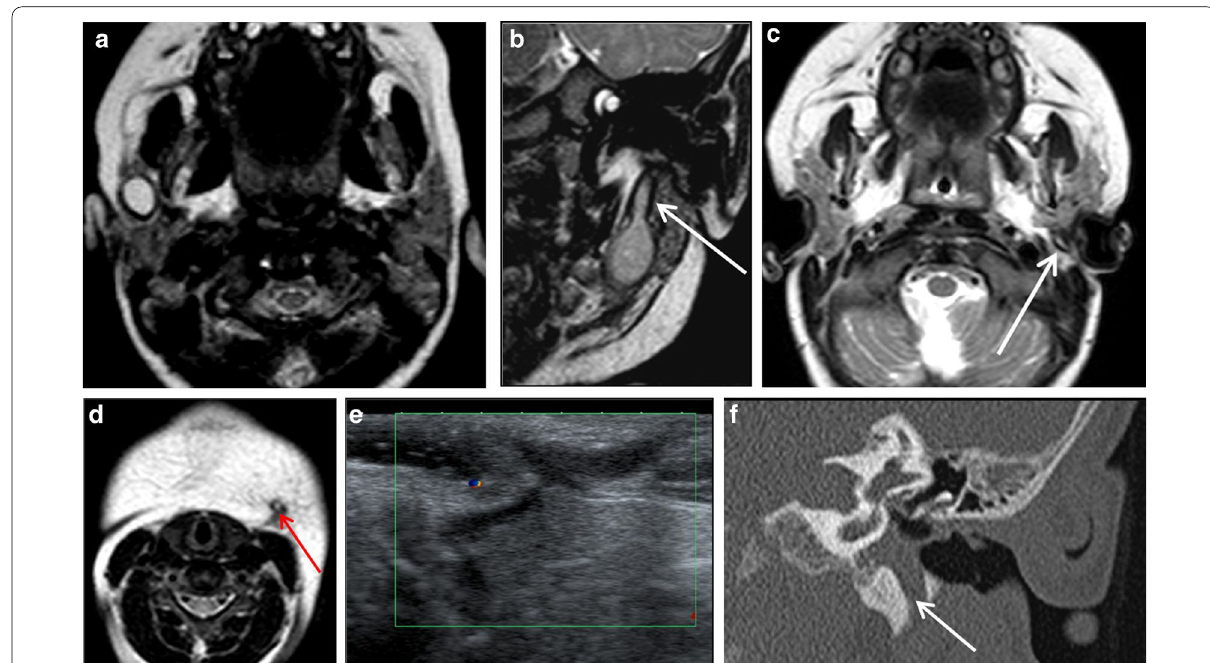
Fig. 11 First branchial‑cleft cyst and fistulas. Right isolated intraparotid cyst on axial T 2 ‑weighted image ( a ). Type II anomaly, with an intraparotid cyst and 2 fistulas, the upper fistula running from the cyst to the external auditory canal [white arrow] and the lower running from the cyst to the skin, in Pochet’s triangle [red arrow] ( b , c and d ). Isolated fistula running from the parotid area to the skin ( e ). Congenital defect of the floor of the left external auditory canal (tympanal bone) on frontal and axial CT images ( f and g